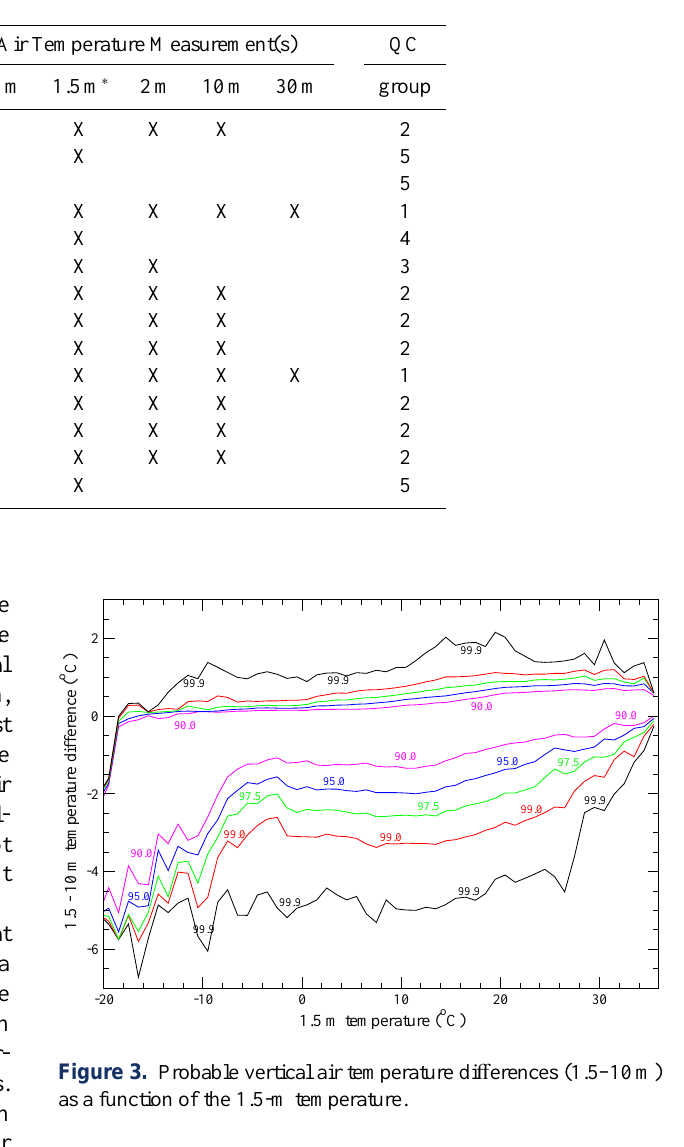
quality checked, then the data fails the horizontal consistency test. Otherwise, we test on a 10-min basis whether the ana- lyzed station value falls inside a confidence interval formed from surrounding stations data that were not classified as out- liers. Measurements that fail the test are flagged as suspect or erroneous depending upon the departure of the data from the confidence interval. Because the horizontal consistency test has been found to report numerous false positive identi- fication in the 10-min air temperature records performed at our two remotest and highest stations (i.e., AWSs code 6484 and 6494 in Fig. 1, respectively), the algorithm does not re- port a horizontal anomaly for these stations. Only the result of the outlier detection is considered by the decision making